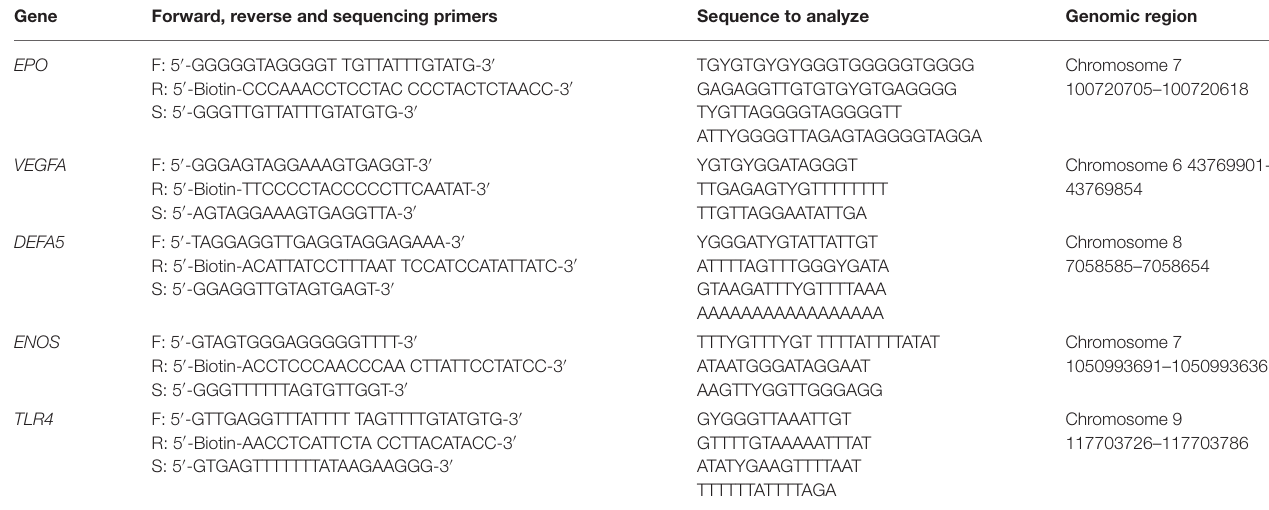
TABLE 1 | PCR forward and reverse primer sequences accompanied by sequencing primer and the sequence to analyze, with its genomic region (Homo sapiens GRCh38.p12 primary assembly). Gene Forward, reverse and sequencing